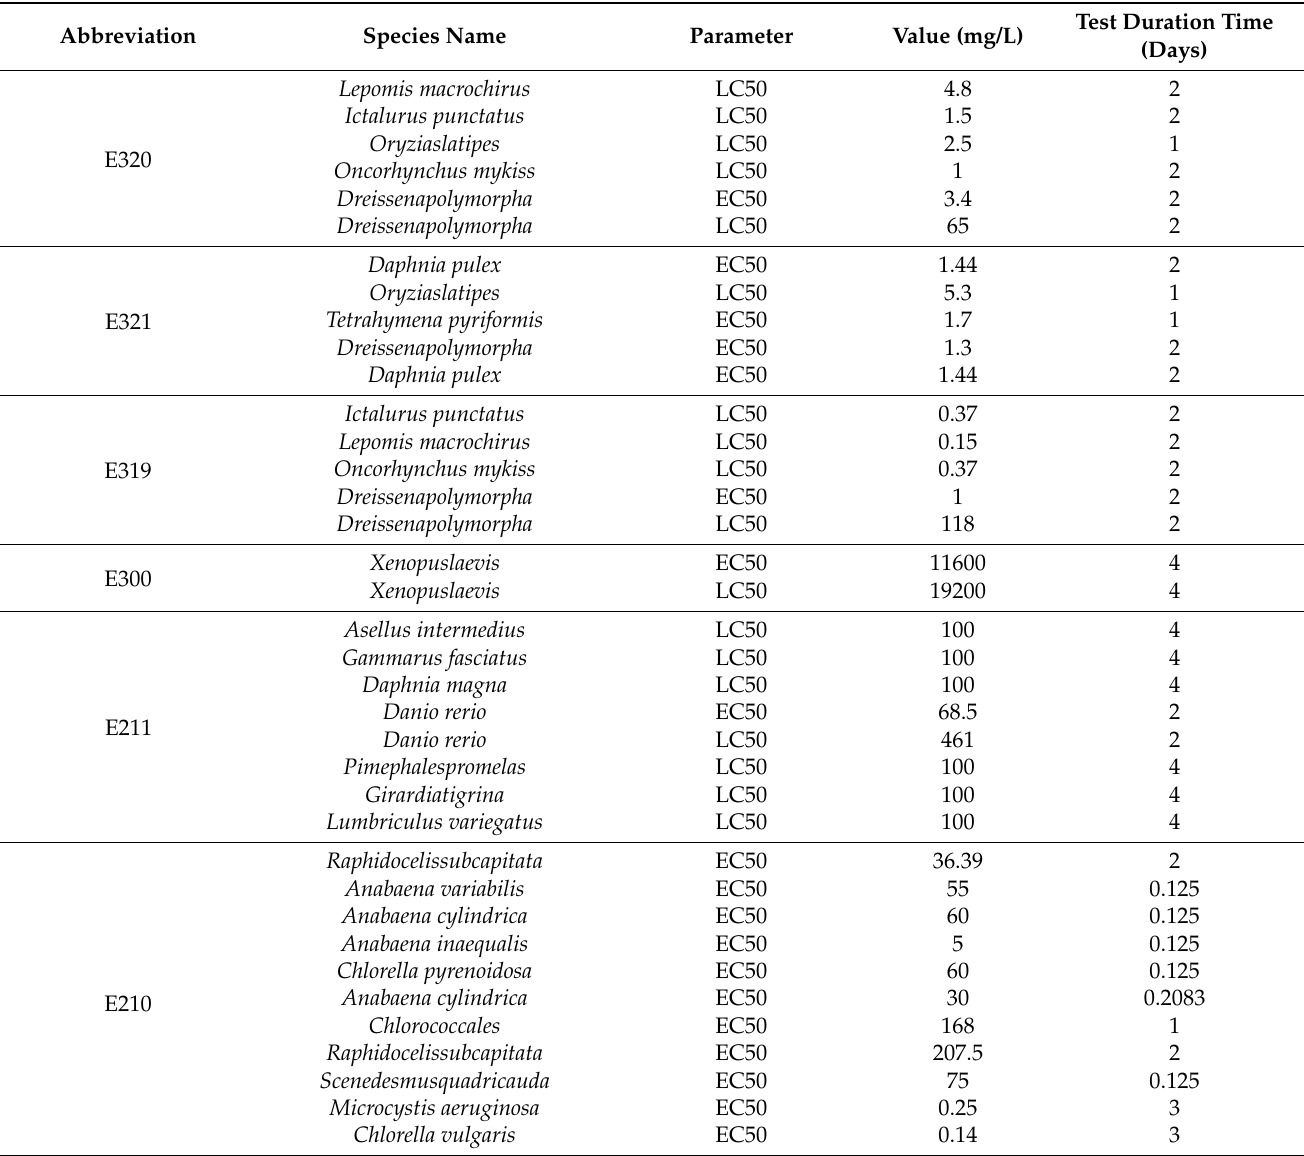
Table 7. Toxicity of the tested food additives to aquatic organisms